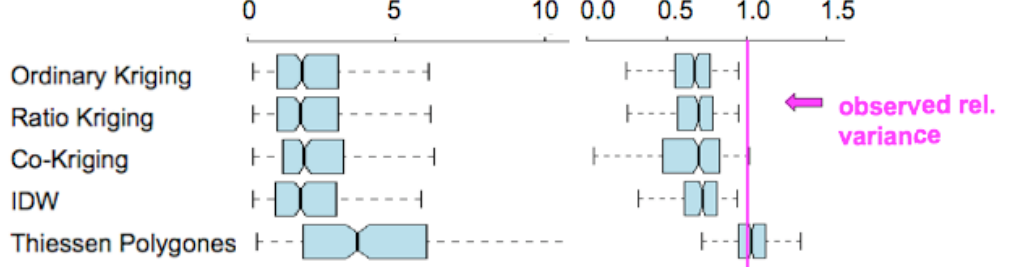
Figure 5. Comparison of di ff erent interpolation methods using cross validation. The box plots indicate RMSE (left), and relative variances (right) found for all days in